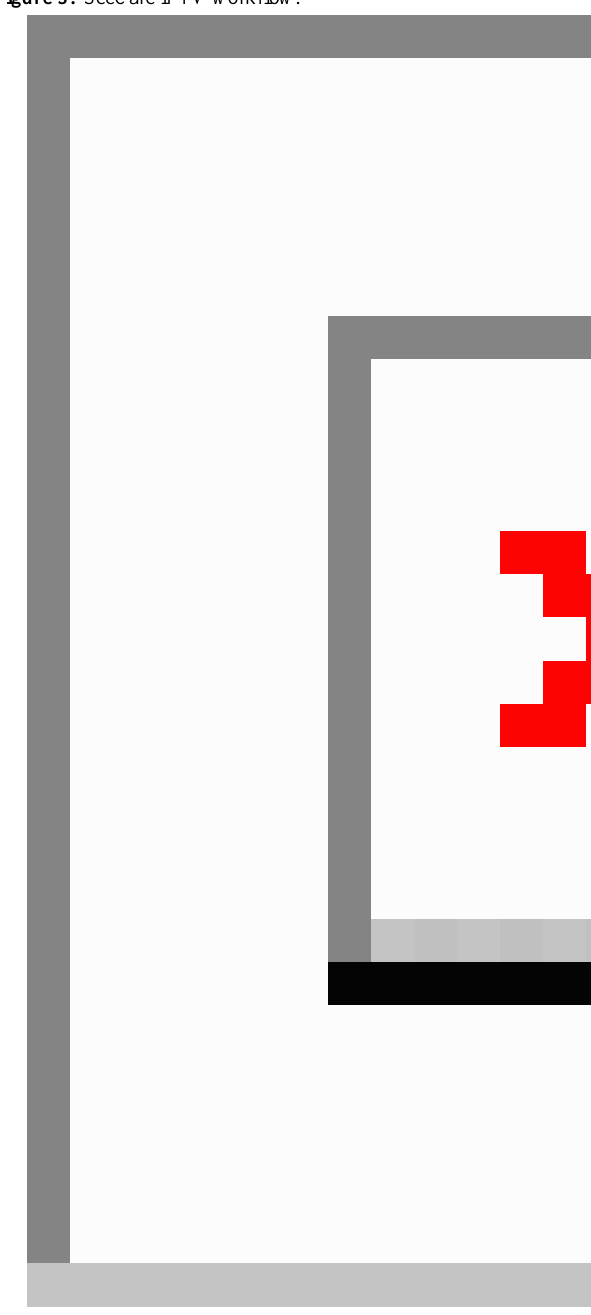
Figure 3. SeeCare IPTV